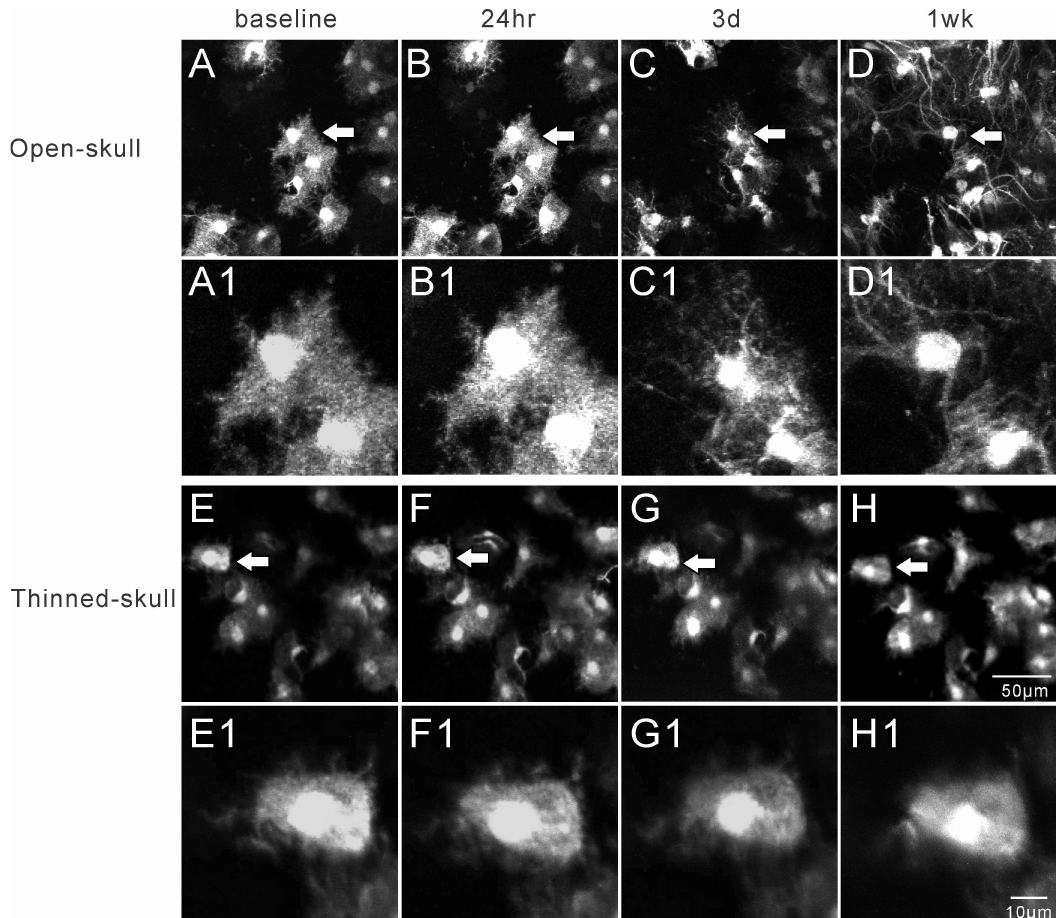
Fig 2. Representative in vivo images of astrocytes after open-skull technique(A-D) and thinned-skull technique(E-H) over a 1wk period. The arrows in figures A-H denote the astrocytes that are enlargedas in figure A1-H1, respectively. Astrocytes typicallyhave a characteristic bushy appearance consistingof thin processesas shown in A1 and E1. After open-skull surgery, the size of astrocytes and their somas decreased at 3 d and 1 wk, but the number of astrocytes increasedat 1 wk. Three days after open-skull surgery, the astrocytes started to lose their classical bushy appearance with fine processes and developextensionand hypertrophyof individualprocesses (C1, D1). No significantchangeswere observedin astrocytes after thinned-skull surgery over 1wk period(E-H,